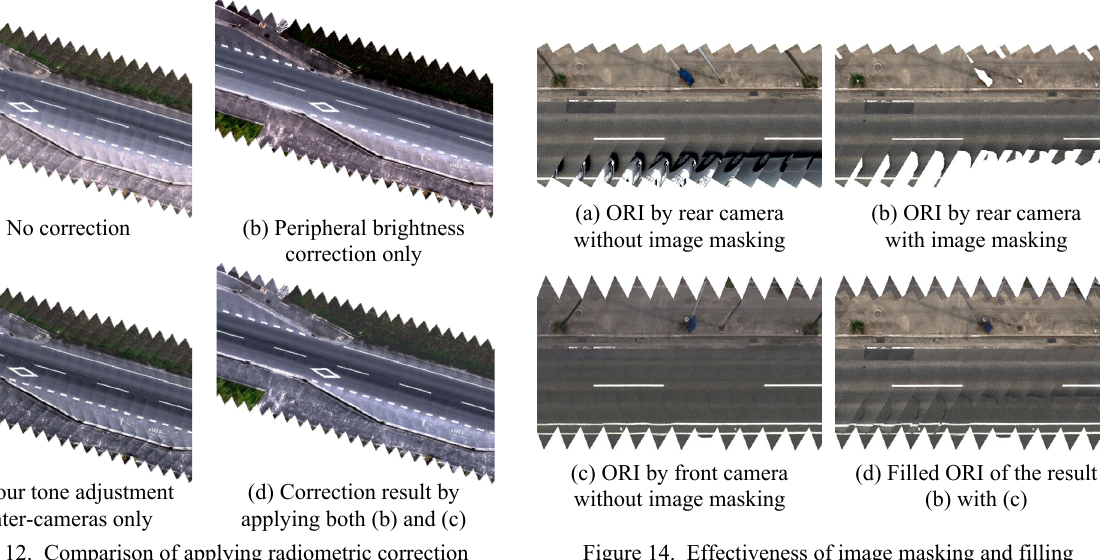
Figure 12. Comparison of applying radiometric correction and/or colour tone adjustment